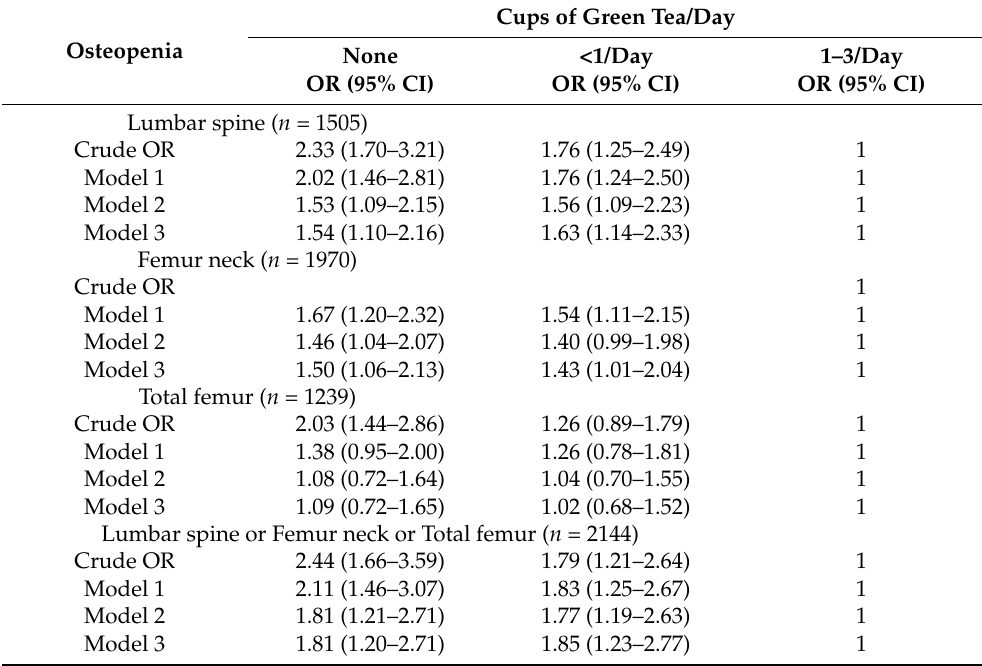
Table 4. The odds ratios for osteopenia according to green tea intake.